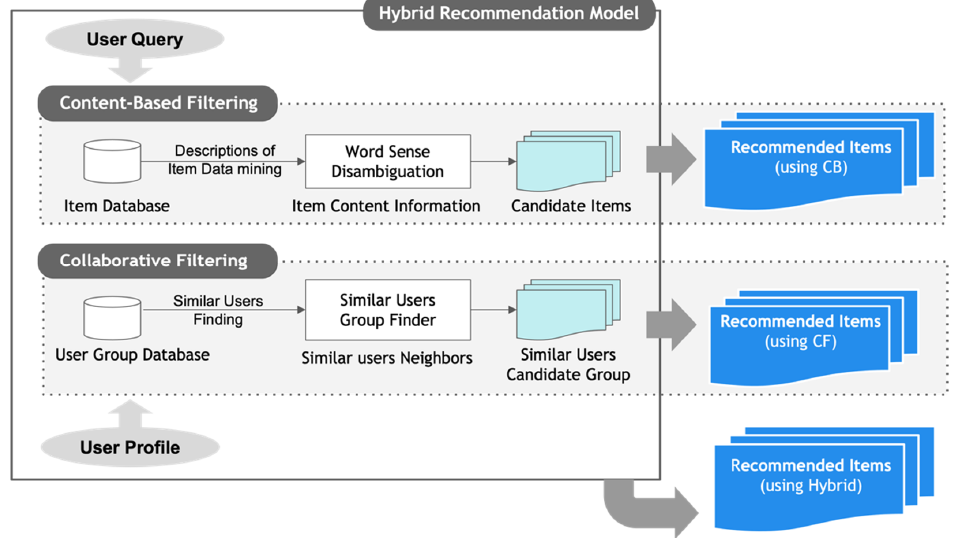
Figure 8. Recommendation principle of Hybrid recommendation model.